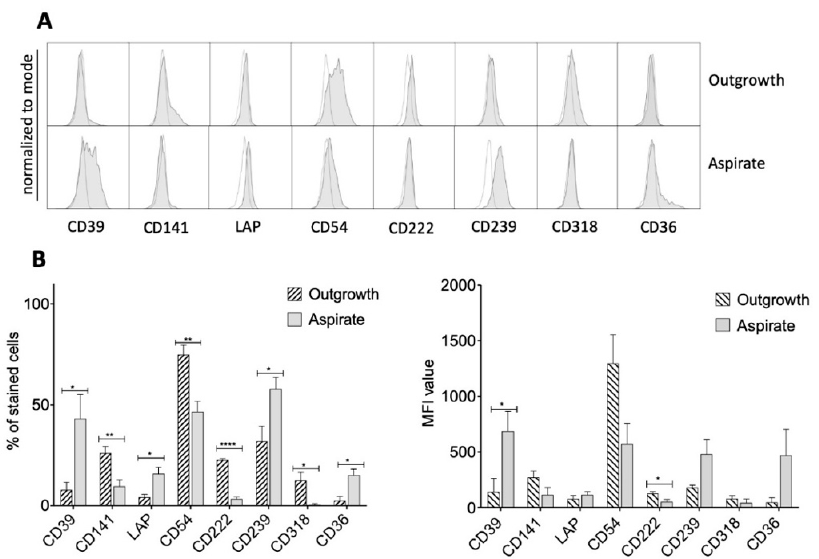
Figure 4. MSC markers of potential interest. ( A ) Representative histograms of further detected differences between outgrowth and aspirate cells (gray histograms). White histograms represent controls. ( B ) CD39, LAP, CD239, CD318 and CD36 showed low significance levels in percentages of cells stained for the given markers. For CD141 and CD54, this difference was medium, and for CD222, highly significant. MFI values indicate significant differences for CD39 and CD222 expression as well. * p < 0.05, ** p < 0.01, **** p < 0.0001.